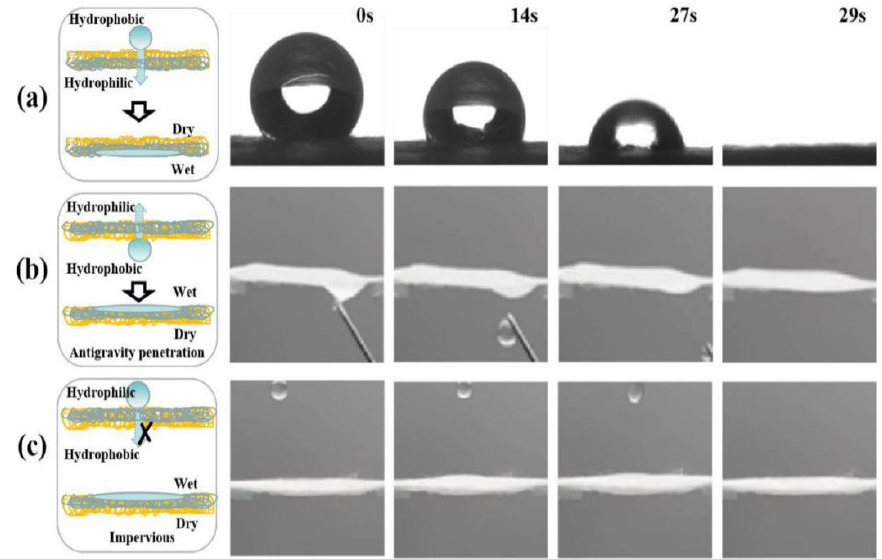
Figure 10. Centrifugal spinning Janus–CA fiber membrane the unidirectional water transfer diagram: ( a ) water droplets penetrate from the hydrophobic surface to the hydrophilic surface; ( b ) reverse gravity penetration; ( c ) water droplets spread on the hydrophilic surface.